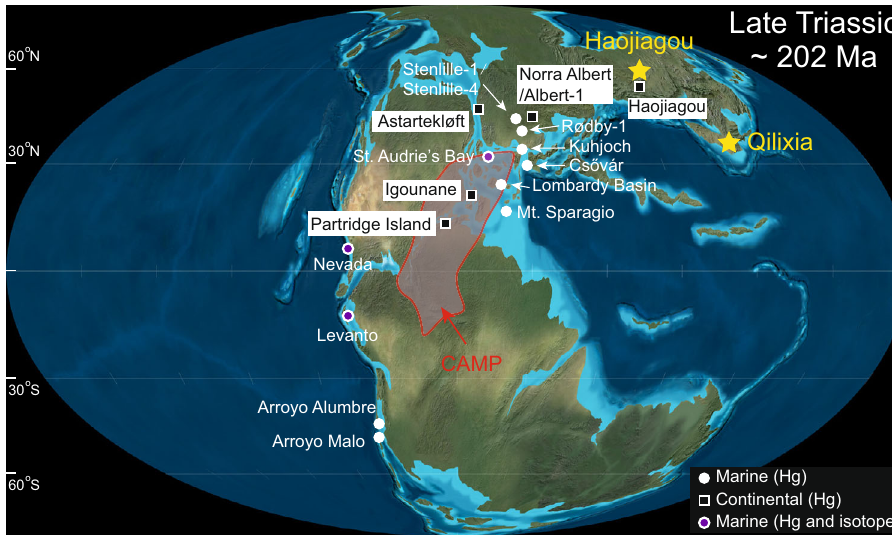
Fig. 1 Geobal paleogeography of the Late Triassic (~200 Ma). Adapted from Ron Blakey, http:// https://deeptimemaps.com/, © 2016 Colorado Plateau Geosystems Inc. Yellow stars represent the study sites, including. The Haojiagou section (~60°N, high latitude) on the North China Craton, and the Qilixia section (~30 – 40°N, low/middle latitude) on the South China Craton. Circles and squares represent other marine and continental sections, respectively, for which mercury data have been generated, including Hg concentrations and isotopes for Nevada 5, 36 , St. Audrie ’ s Bay 34, 36 , and Levanto 36 ; and Hg concentrations for Arroyo Malo 34 , Astartekløft 34 , Igounane 34 , Kuhjoch 34 , Partridge Island 34 ; Stenlille-1/Stenlille-4 46 , Rødby-1 46 , Norra Albert/Albert-1 46